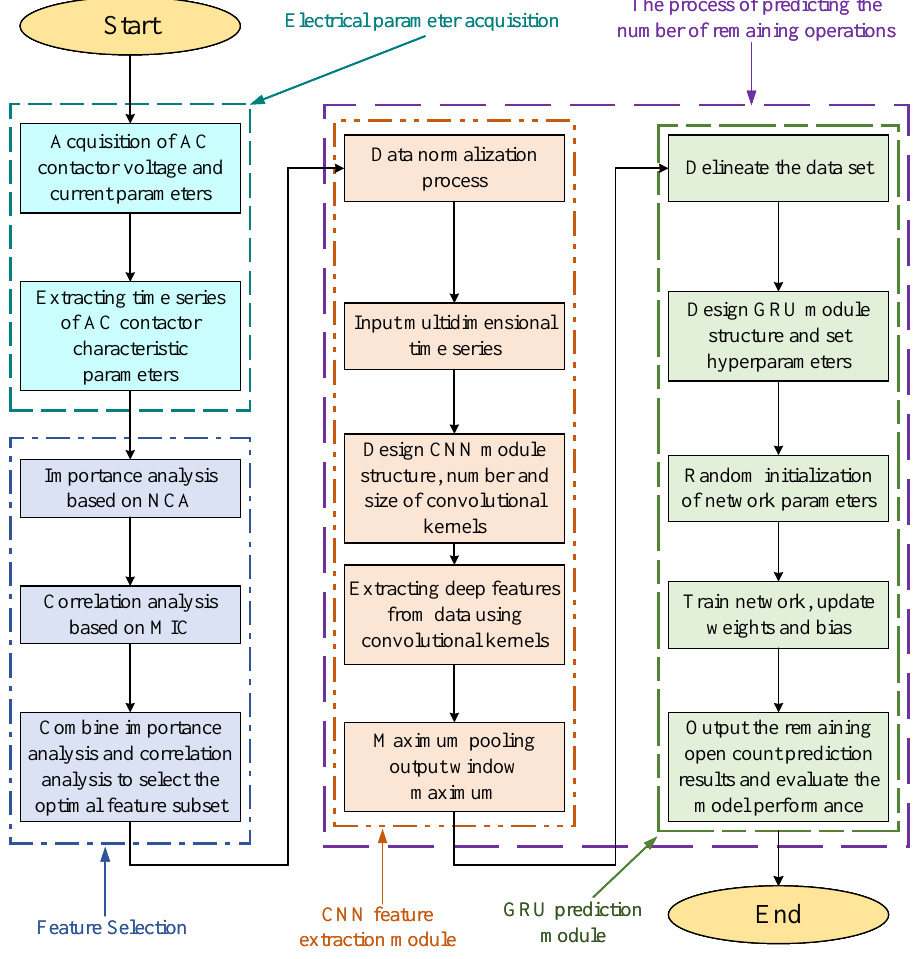
Figure 4. Schematic diagram of the model